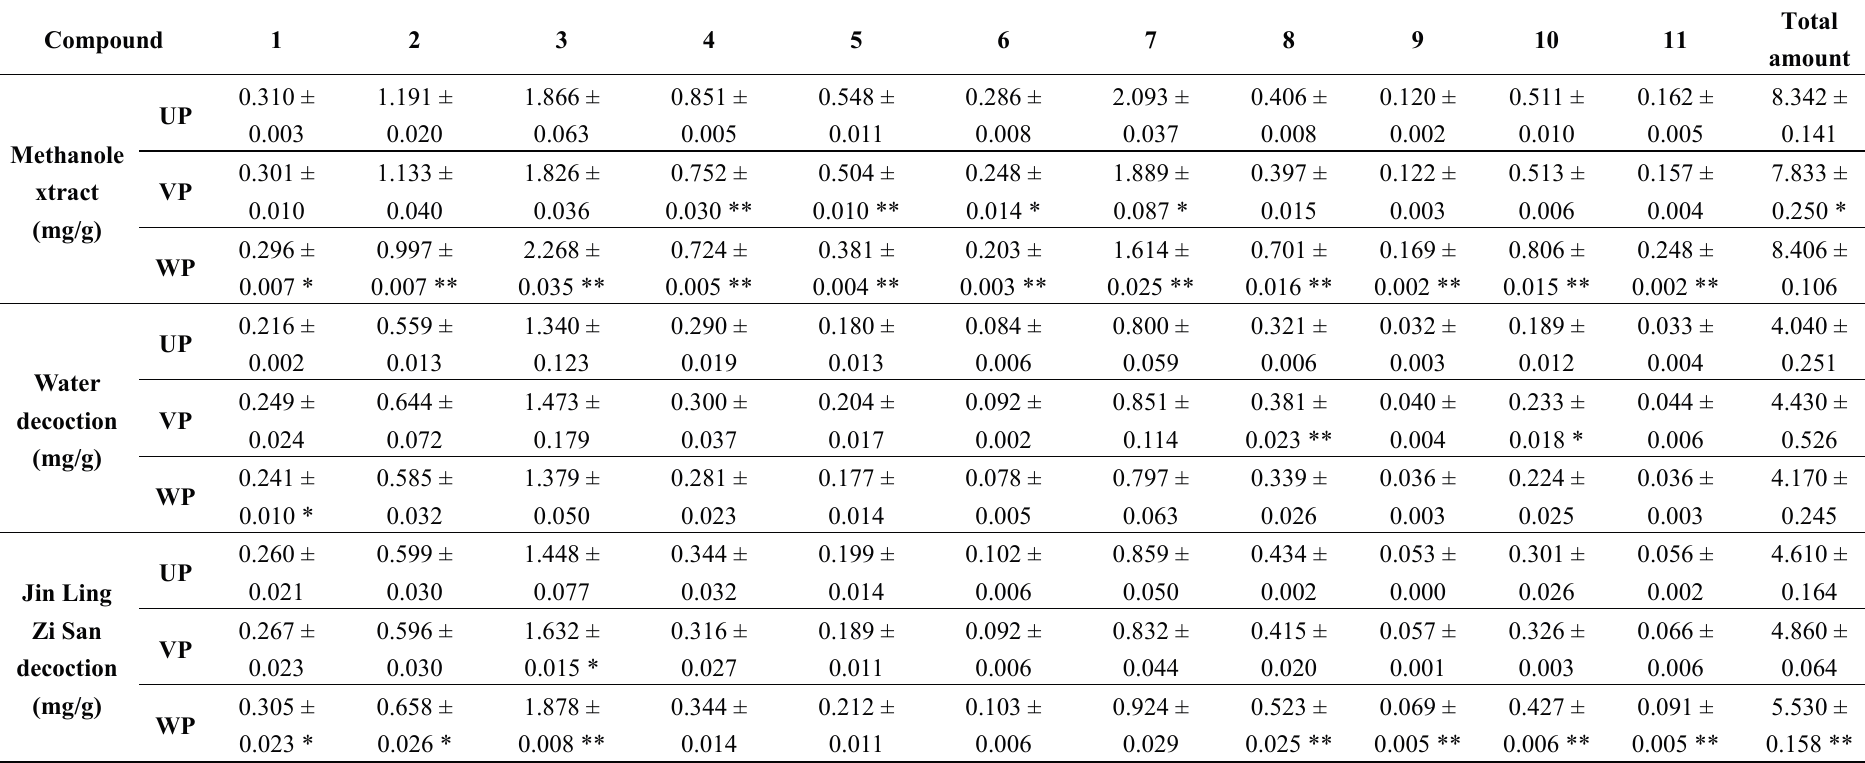
Table 4. Alkaloid content of unprocessed and processed Corydalis